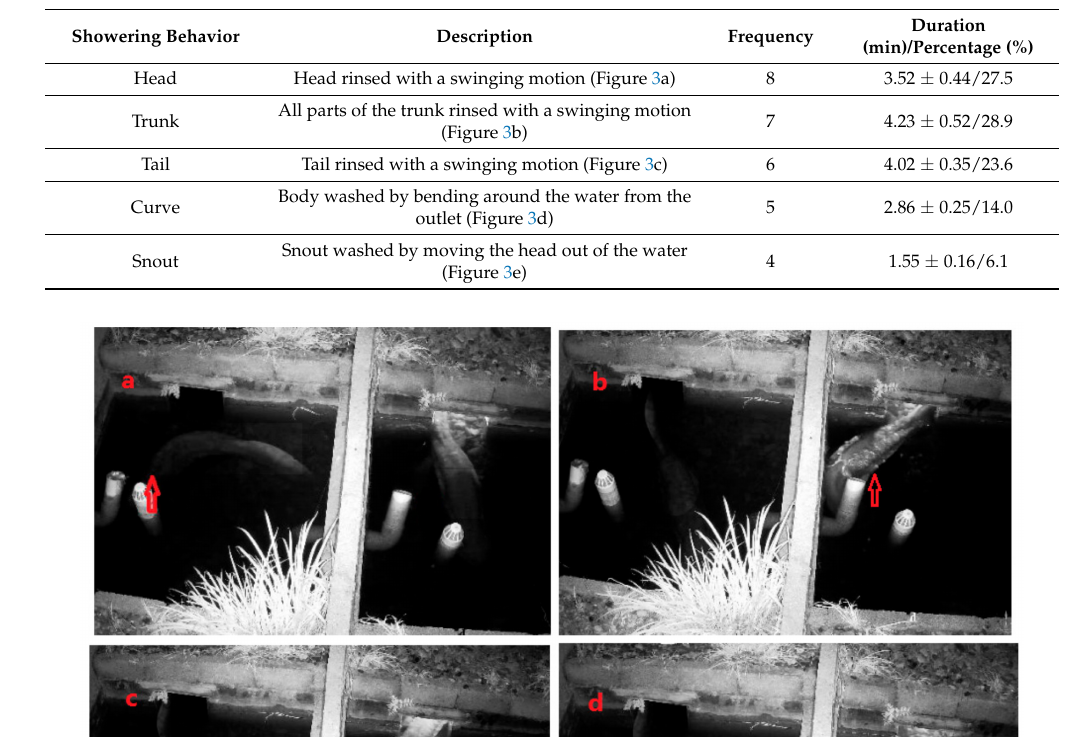
Table 2. Description of showering behavior in male A. davidianus.